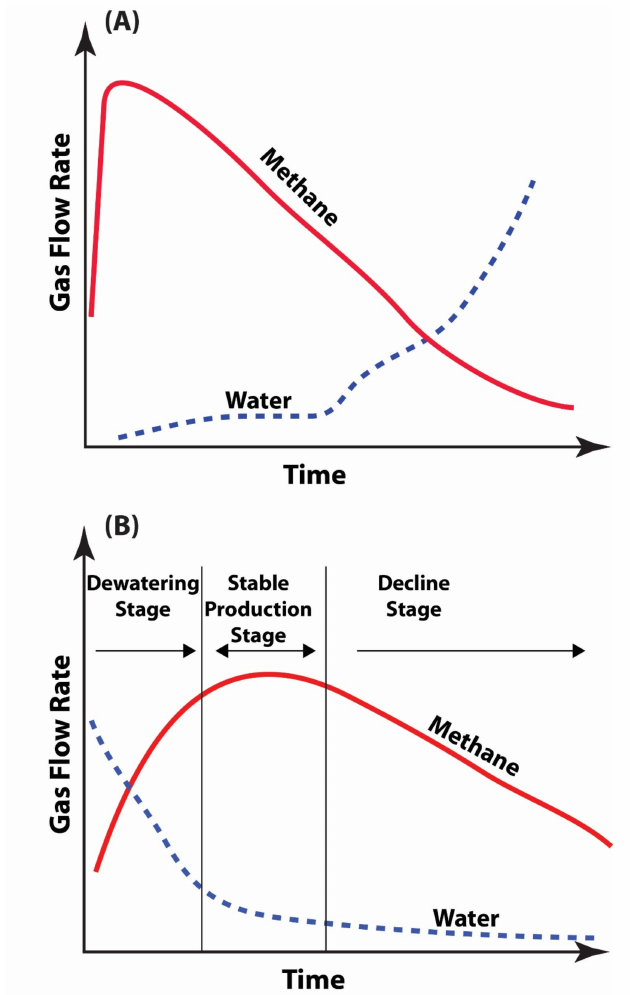
Figure 3. Differences in production profiles from a ( A ) conventional natural gas well and ( B ) CSG